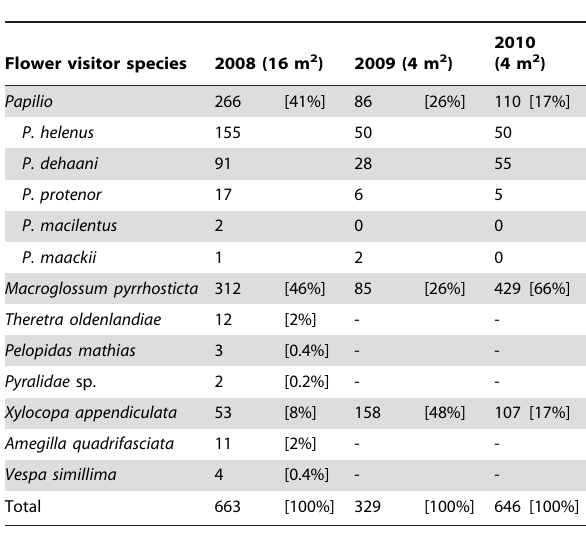
Table 1. Frequencies of flower visitors in C. trichotomum